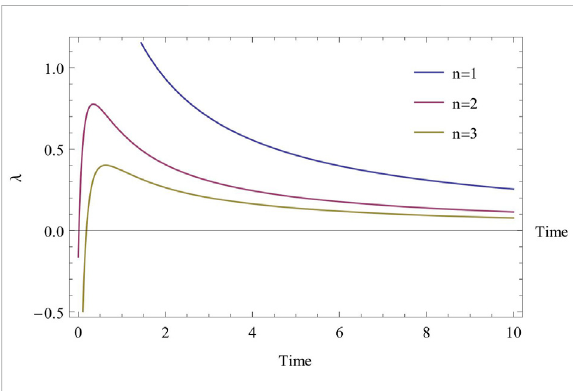
FIGURE 5 The plot of tension density of the string λ versus time t.